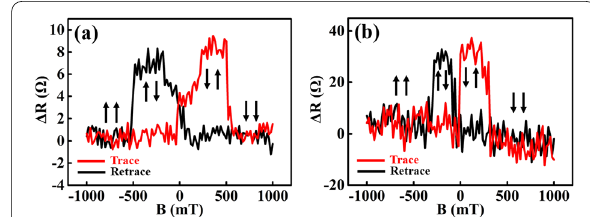
Fig. 4 ( a ) ΔR dependence on the in-plane magnetic field for the grown n-GaN with a carrier concentration of ~ 10 17 cm − 3 ; ( b ) ΔR dependence on the in-plane magnetic field for the free-standing single-crystal n-GaN with a carrier concentration of ~ 10 18 cm − 3